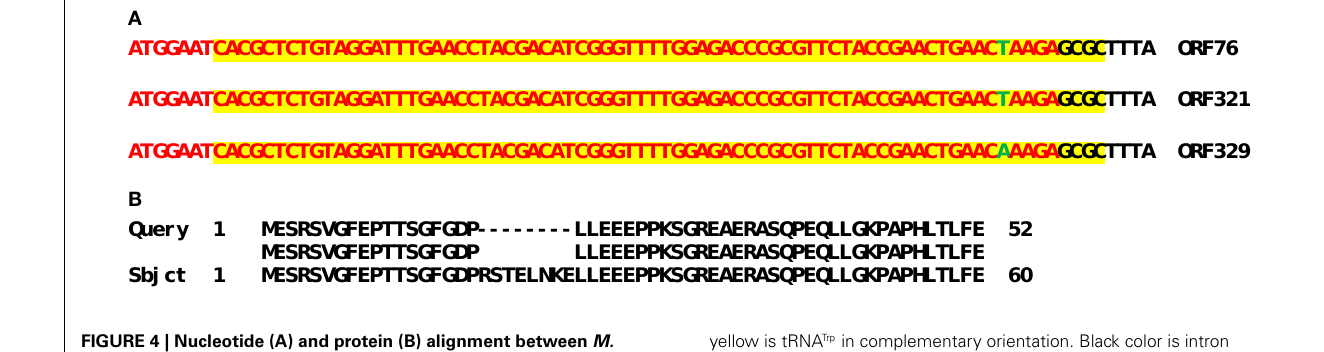
yellow is tRNA Trp in complementary orientation. Black color is intron sequence. Green color shows point mutation. (B) An alignment between exon 1 (first 18 amino acids) and part of exon 2 sequences. Query is a sequence of ORF76 or ORF321, Sbjct is a sequence of